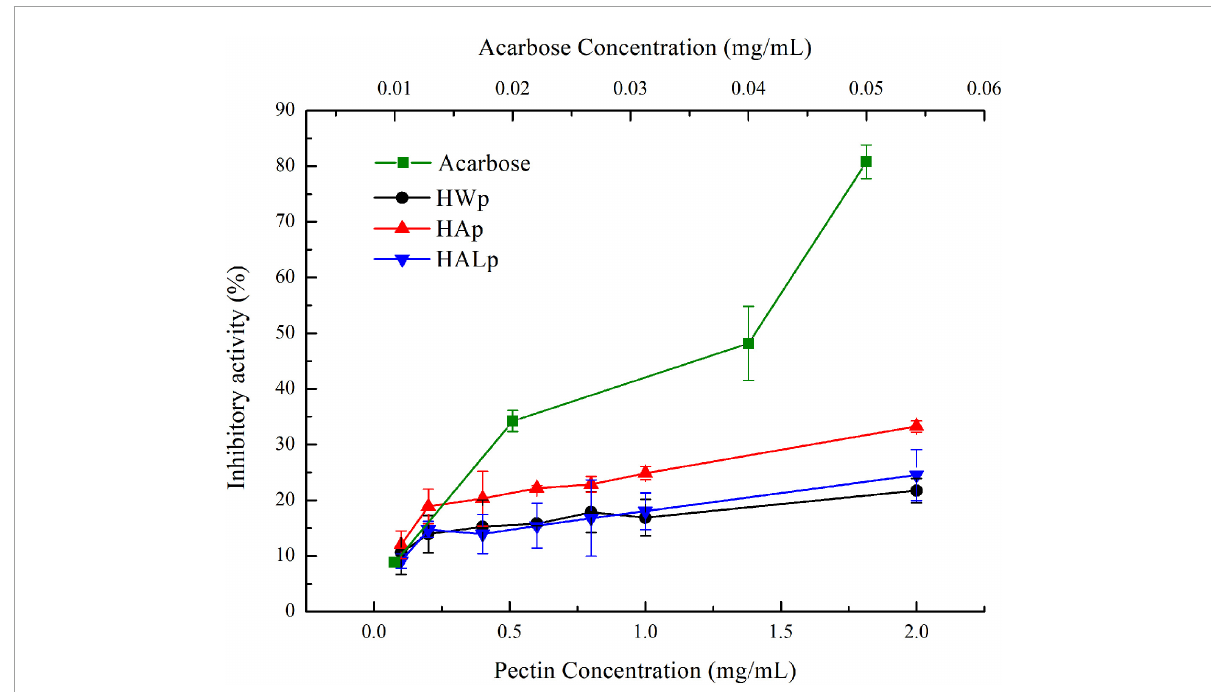
FIGURE5 Different concentrations of HWp, HAp, HALp, and acarbose glucosidase inhibition efficiency.